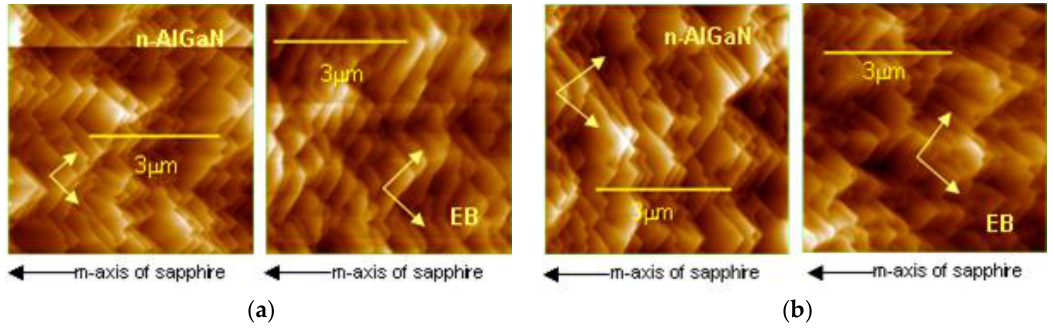
Figure 10. AFM images of n-Al x Ga 1−x N surface and EB surface used to determine the external forms of uneven QWs for: ( a ) x = 0.61 (265 nm LEDs); and ( b ) x = 0.67 (285 nm LEDs). The Ra values for the height plots along the yellow lines are 1.38 and 1.12 for the surfaces of n-Al 0.61 Ga 0.39 N and EB layers in ( a ) and 1.42 and 1.43 in ( b ), respectively. The arrows in the AFM images are considered to be the m-axis of the AlGaN. These AFM images are distorted because of the non-contact-mode measurement. (( a , b ) are permitted to be reused from Jpn. J. Appl. Phys. [13]. © Japan Society Applied Physics).